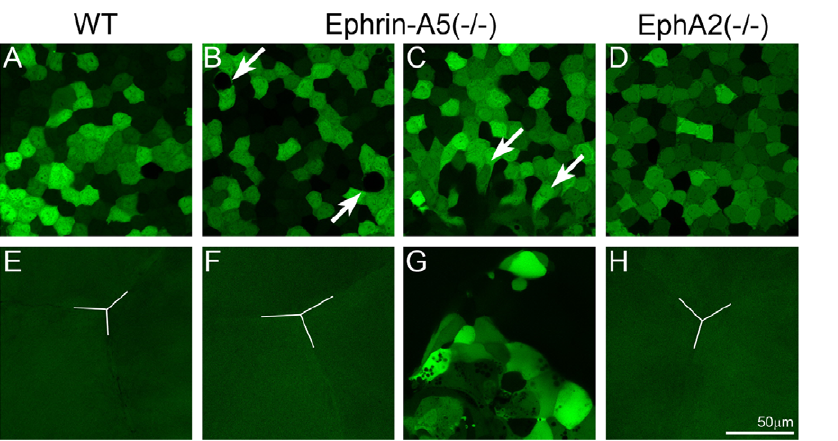
Figure 2. Confocal images of the anterior region of GFP + wild-type (WT), ephrin-A5(-/-) and EphA2 lenses. The WT lens shows typical mosaic GFP expression pattern in the central epithelium (A) and the Y-shape suture (Y-line) of underlying fiber cells (E). An ephrin-A5(-/-) lens displays morphological changes in a few epithelial cells (arrows in B), and the other ephrin-A5(-/-) lens shows a cluster of aberrant cells underneath the central epithelial cells (arrows in C). In addition, mislocalized aberrant cells are apparent in underlying fiber cell layers without the normal Y-shaped suture (G). The EphA2 (-/-) lens has normal central epithelial cells (D) and anterior Y-shaped suture (H). Scale bar, 50 m m.